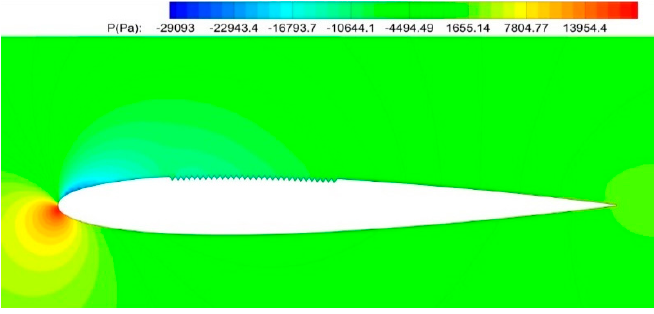
Figure 15. 4° angle of attack, pressure distribution of grooves on the suction side.